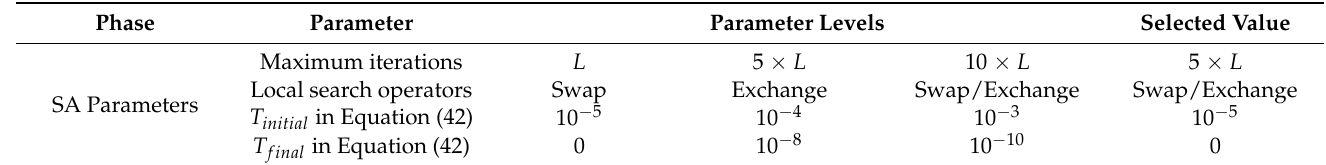
Table 3. SA parameter settings using the Taguchi method.